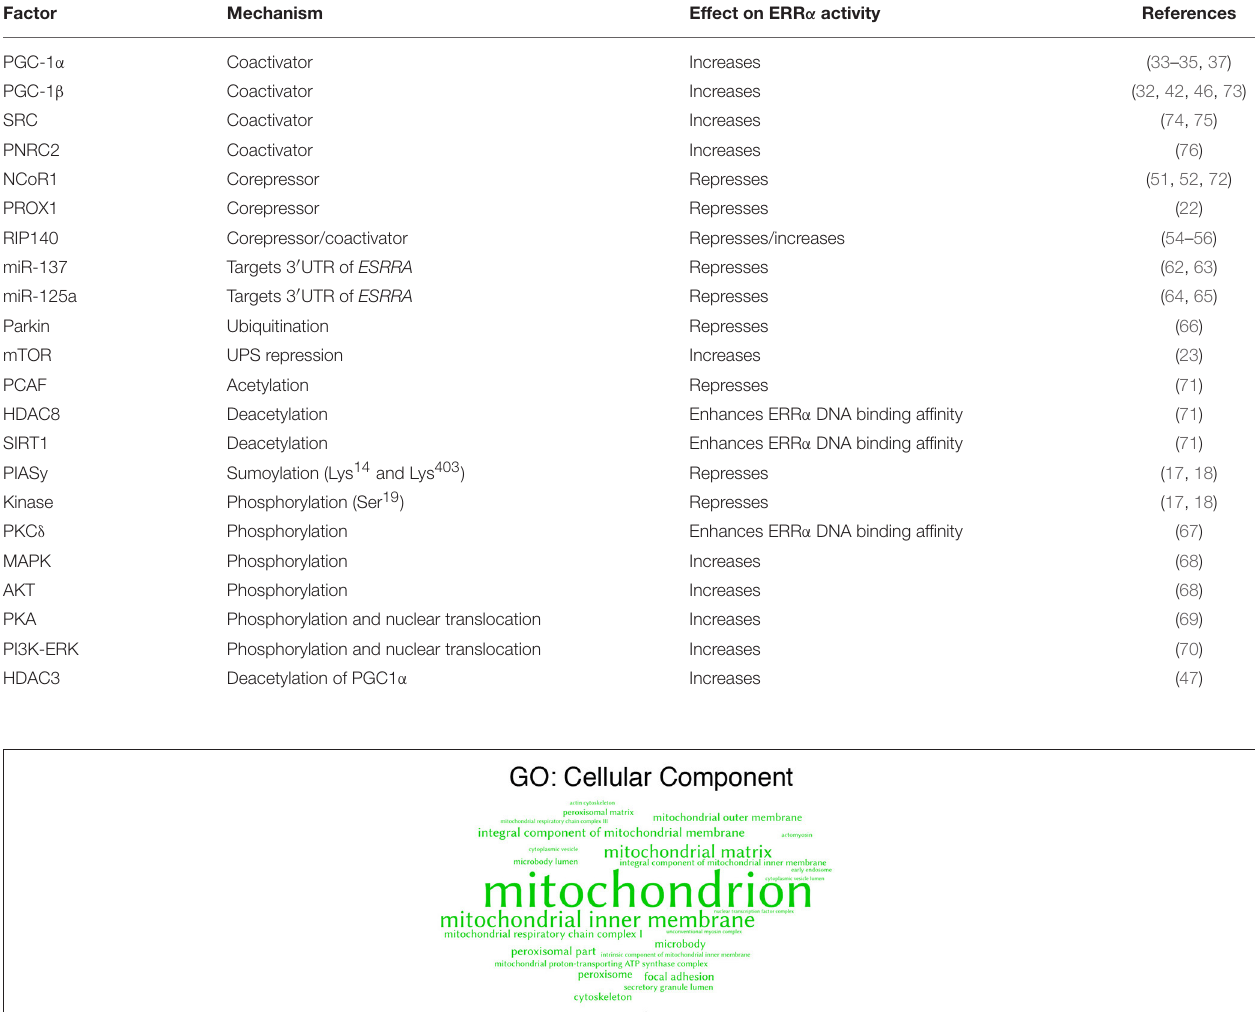
TABLE 1 | Known regulators of ERR α transcriptional activity.